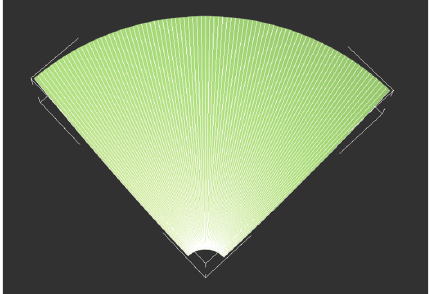
Figure 5: Designed model given by NURBS.